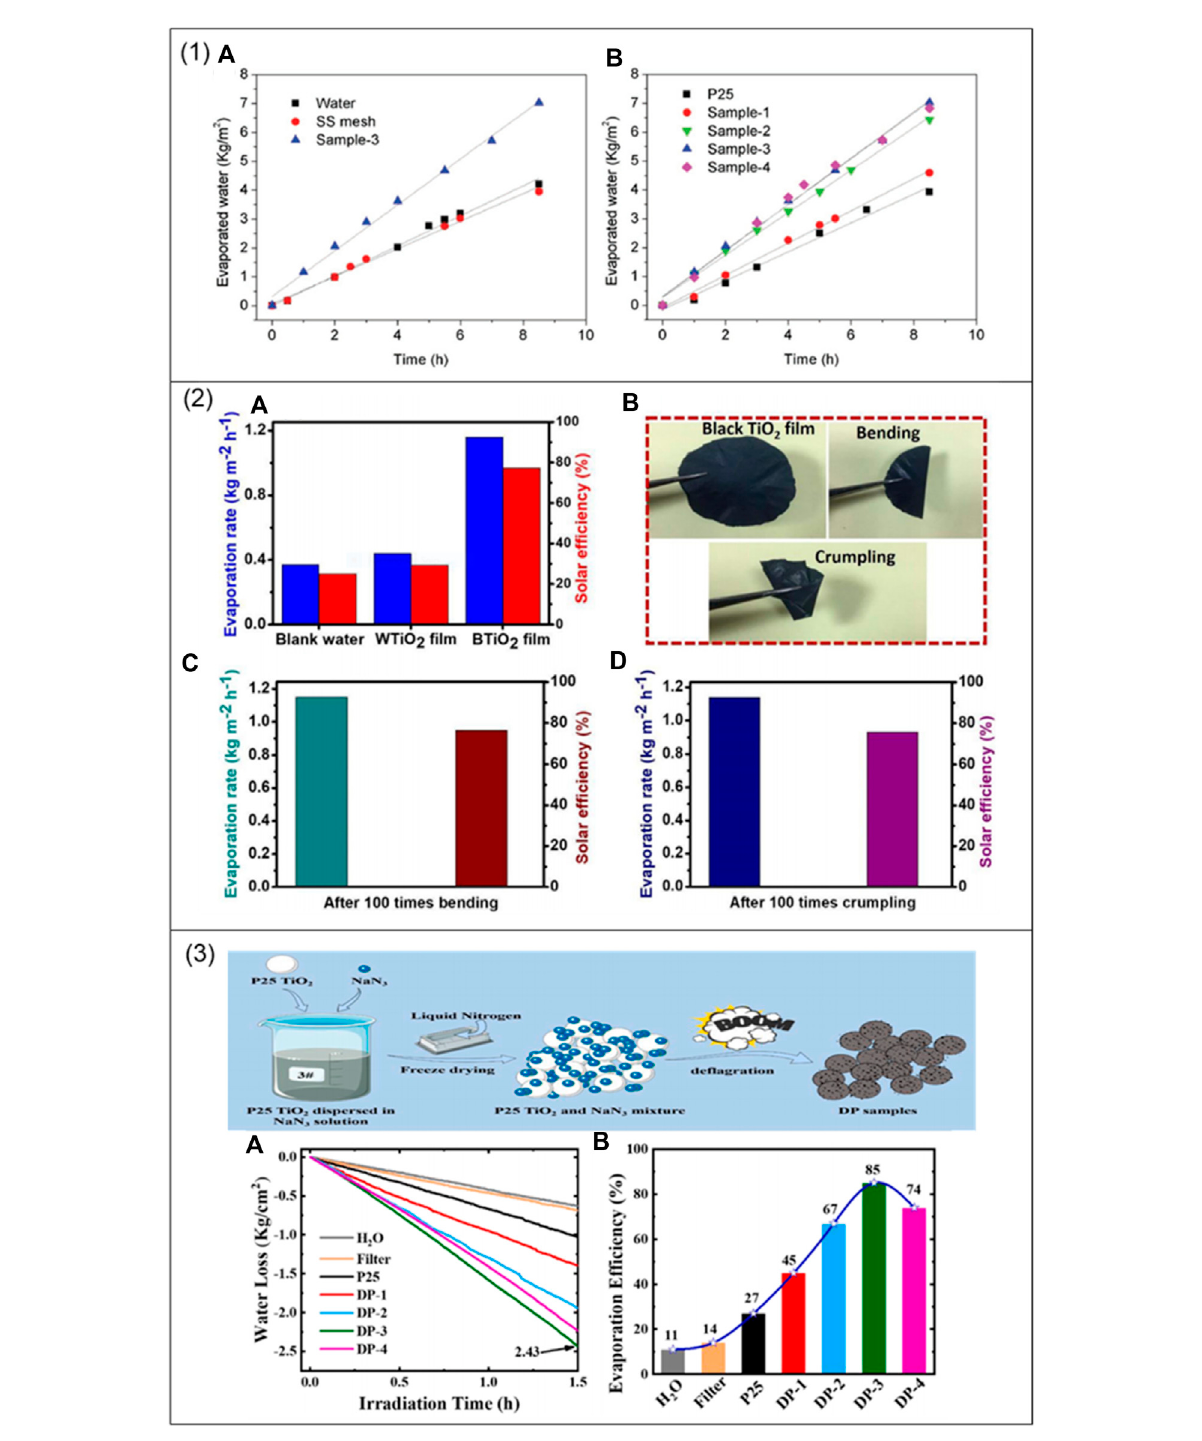
FIGURE 5 (1) Mass of evaporated water as a function of the radiation time in the absence or presence of an SS mesh coated with different TiO x NPs (Ye et al., 2016); Reproduced with permission. Copyright 2016 John Wiley and Sons. (2) (A) Evaporation rate and solar ef fi ciency of blank water, WTiO 2 , and BTiO 2 . (B) Images of BTiO 2 bending and crumpled fi lm. (C, D) Evaporation rates of bending and crumpled BTiO 2 fi lms (Zada et al., 2020); Reproduced with permission. Copyright 2020 Elsevier. (3) Schematic fabrication of DP samples. (A) Evaporation rate of water. (B)